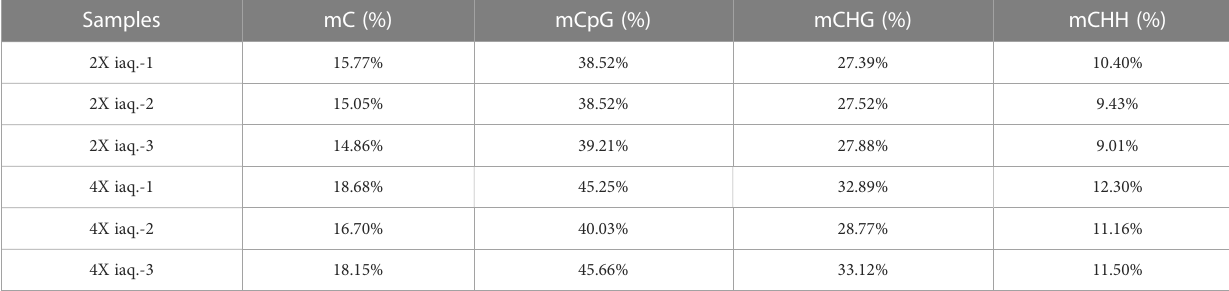
TABLE 1 Genome-wide methylation C site ratio. Samples